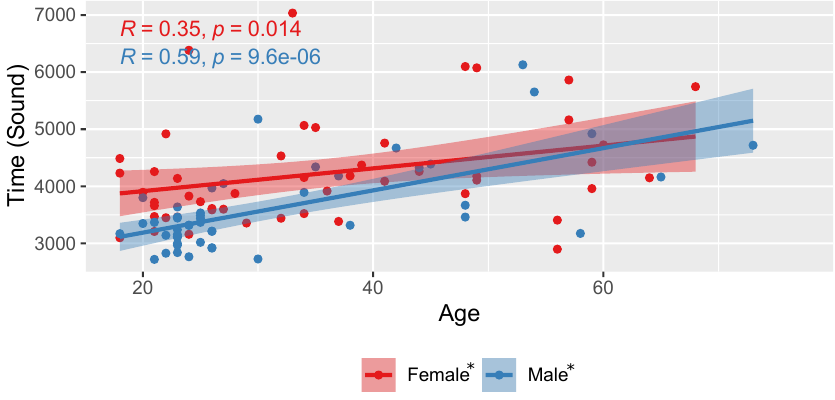
Figure 9. Times of activation versus Age in Sound condition: correlation for males and females dis- played using a scatter plot with regression lines and 95% confidence interval. Significant correlations are marked with asterisk.